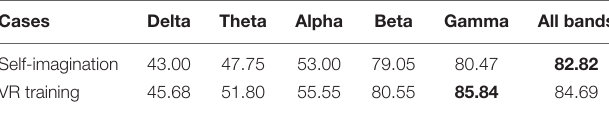
TABLE 5 | Classification accuracy of emotion